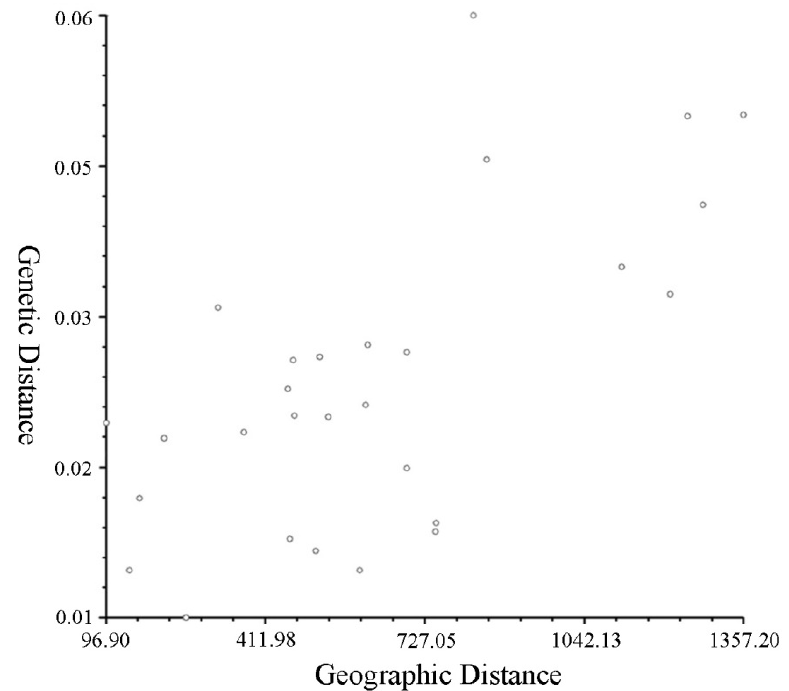
Figure 4. The result of the Mantel test.